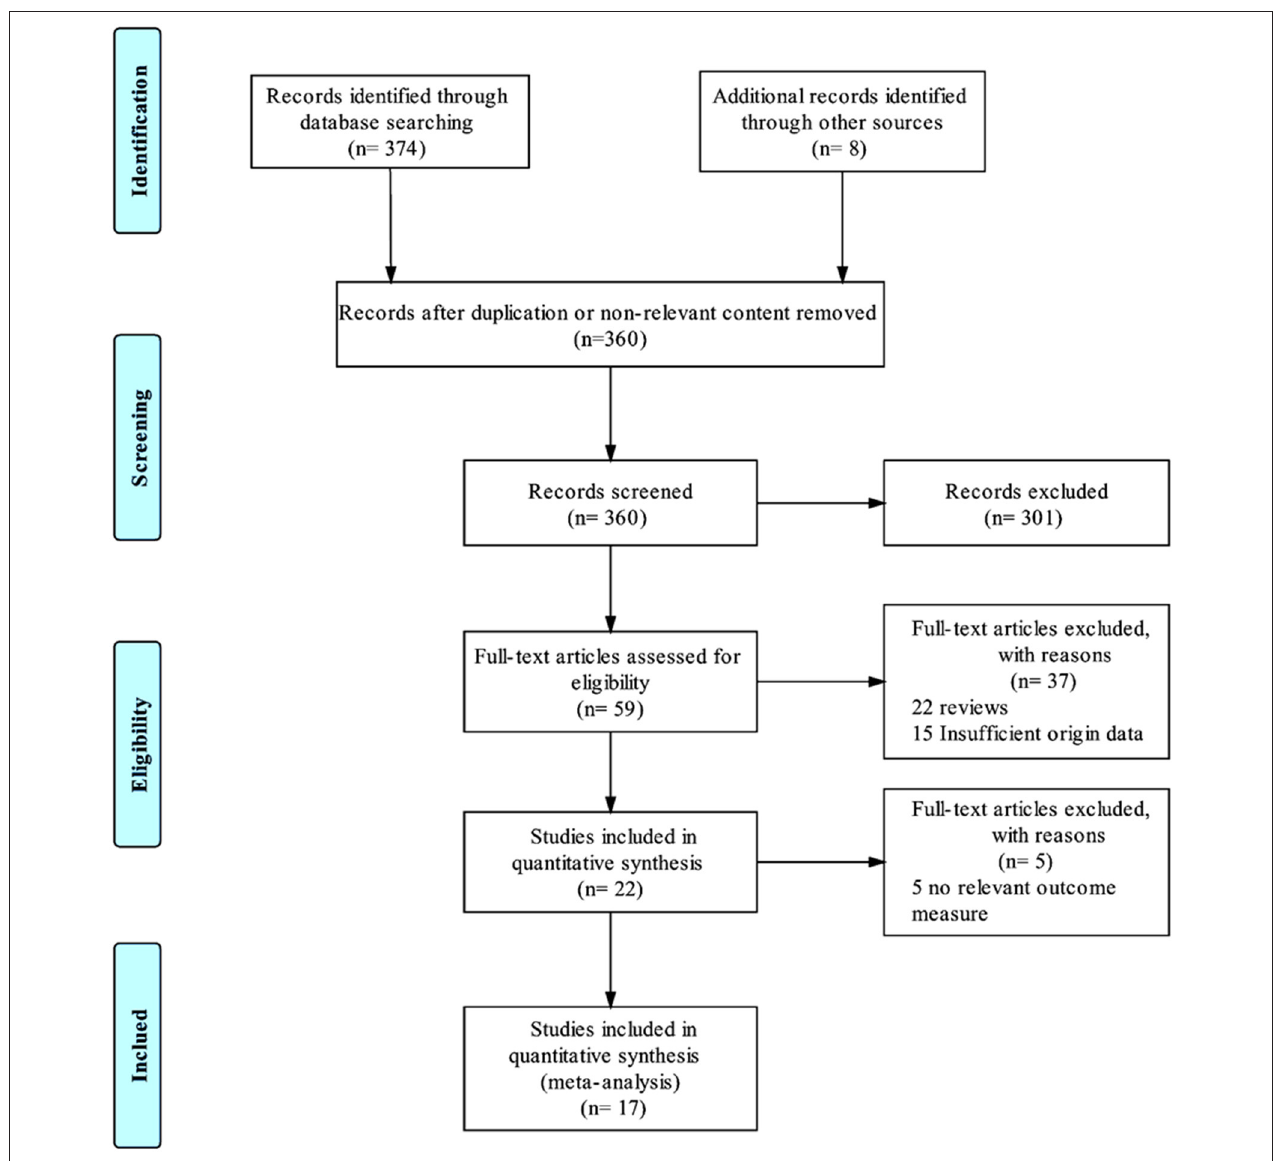
FIGURE 1 | PRISMA flowchart. This flowchart represents the literature selection and elimination process taken to obtain the final 17 studies that were included in this